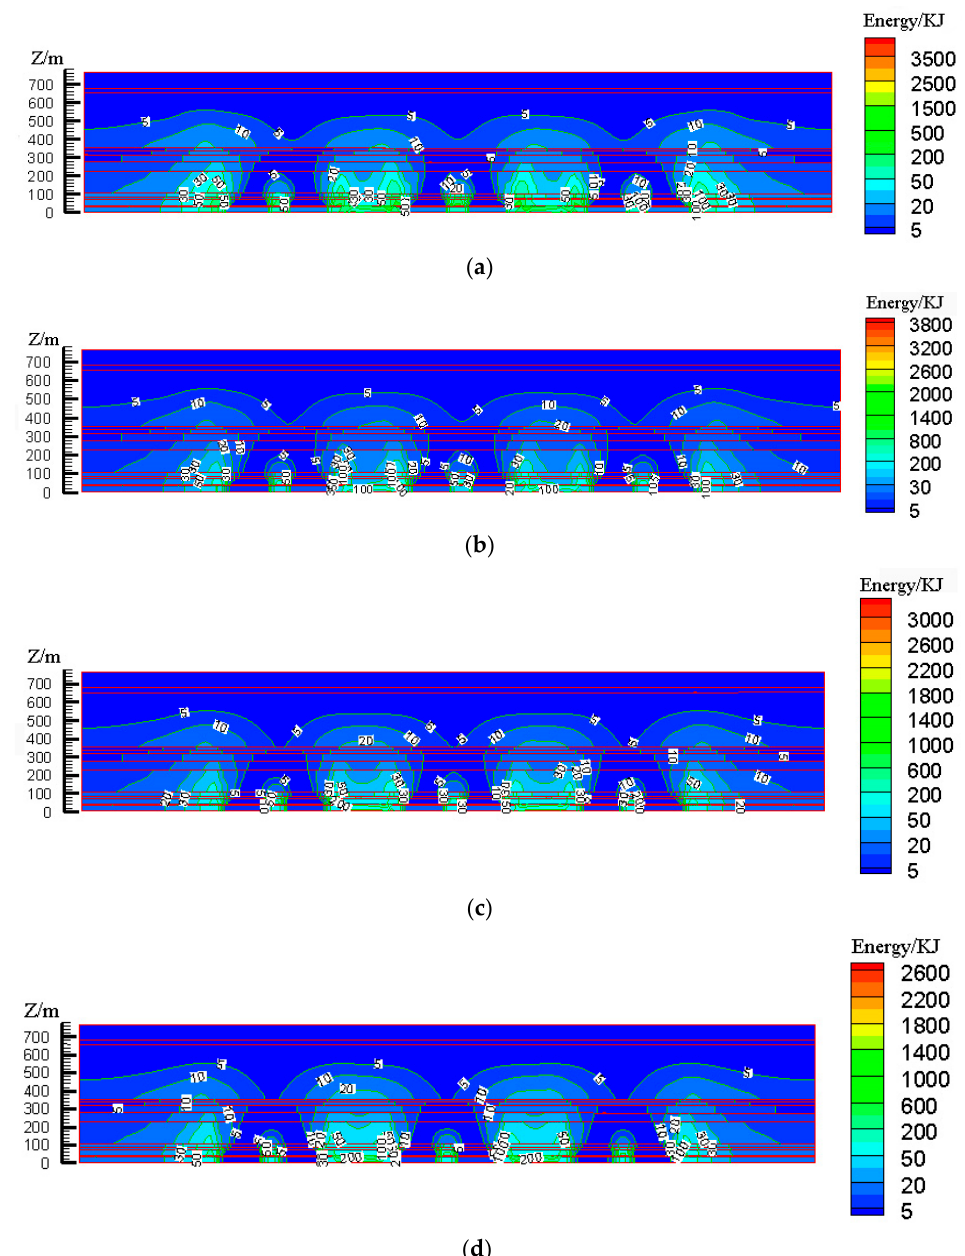
Figure 8. Effects of filling ratio on energy polling distribution characteristics of partial filling mining based on the main key stratum; ( a ) energy polling distribution characteristics of partial filling mining based on the main key stratum (filling ratio = 60%). ( b ) Energy polling distribution characteristics of partial filling mining based on the main key stratum (filling ratio = 70%). ( c ) Energy polling distribution characteristics of partial filling mining based on the main key stratum (filling ratio = 80%). ( d ) Energy polling distribution characteristics of partial filling mining based on the main key stratum (filling ratio = 90%).